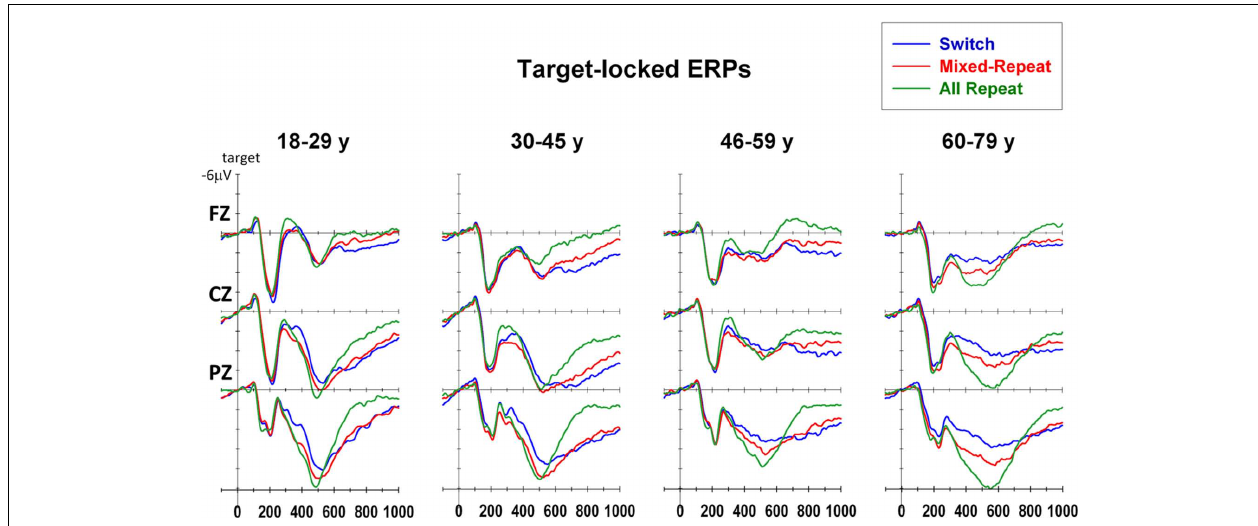
FIGURE 7 |Target-locked event-related potentials for each trial type at midline electrodes.